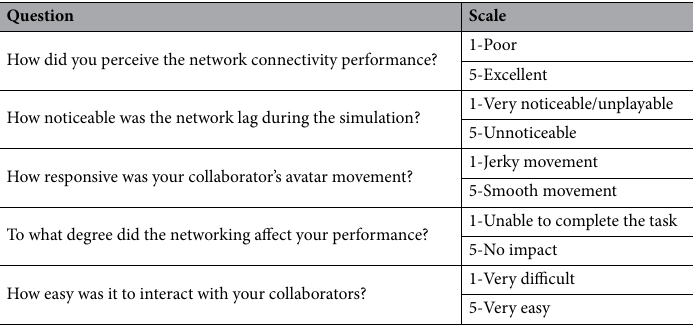
Table 2. Reported questions from post-questionnaire.